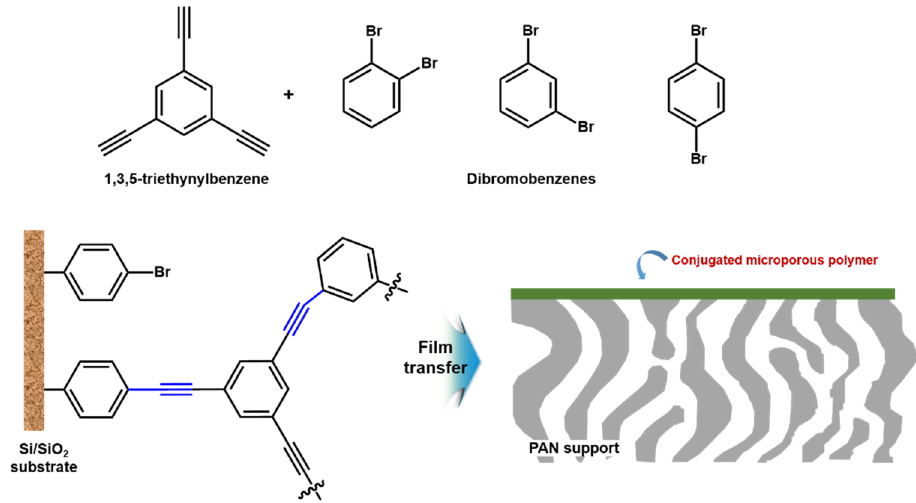
Figure 7. Conjugated microporous polymers (CMP)-based ultra-thin film with microporous voids and conjugated rigid-backbone structures.